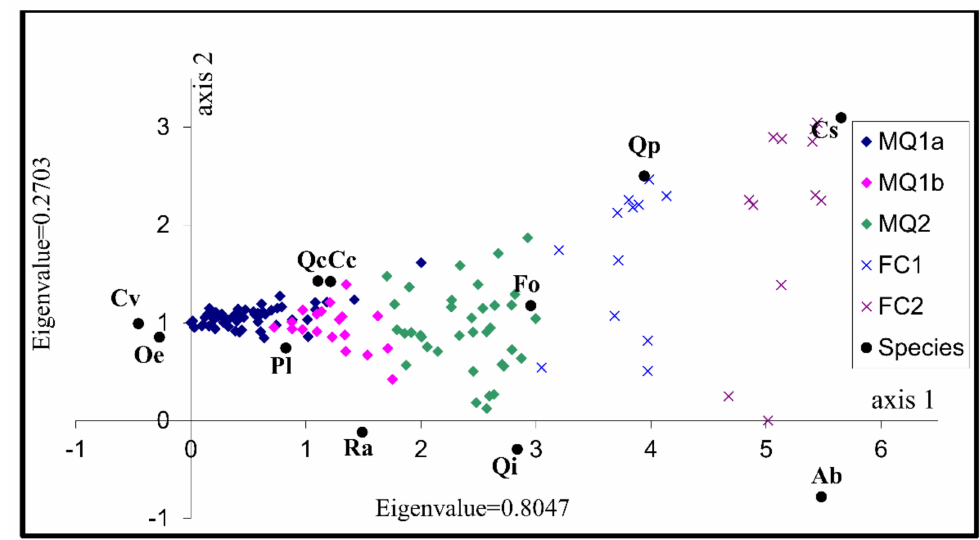
Figure 4. DCA samples-species ordination diagram for axes 1 and 2. Only selected species are displayed. Species codes: Ab = A. borisii-regis , Cc = C. creticus , Cs = C. sativa , Cv = C. villosa , Fo = F. ornus , Oe = O. europaea , Pl = P. latifolia , Qc = Q. coccifera , Qi = Q. ilex , Qp = Q. petraea , Ra = R. alaternus . Samples are arranged into five groups that represent the final communities and sub-communities identified by TWINSPAN in the classification analysis.